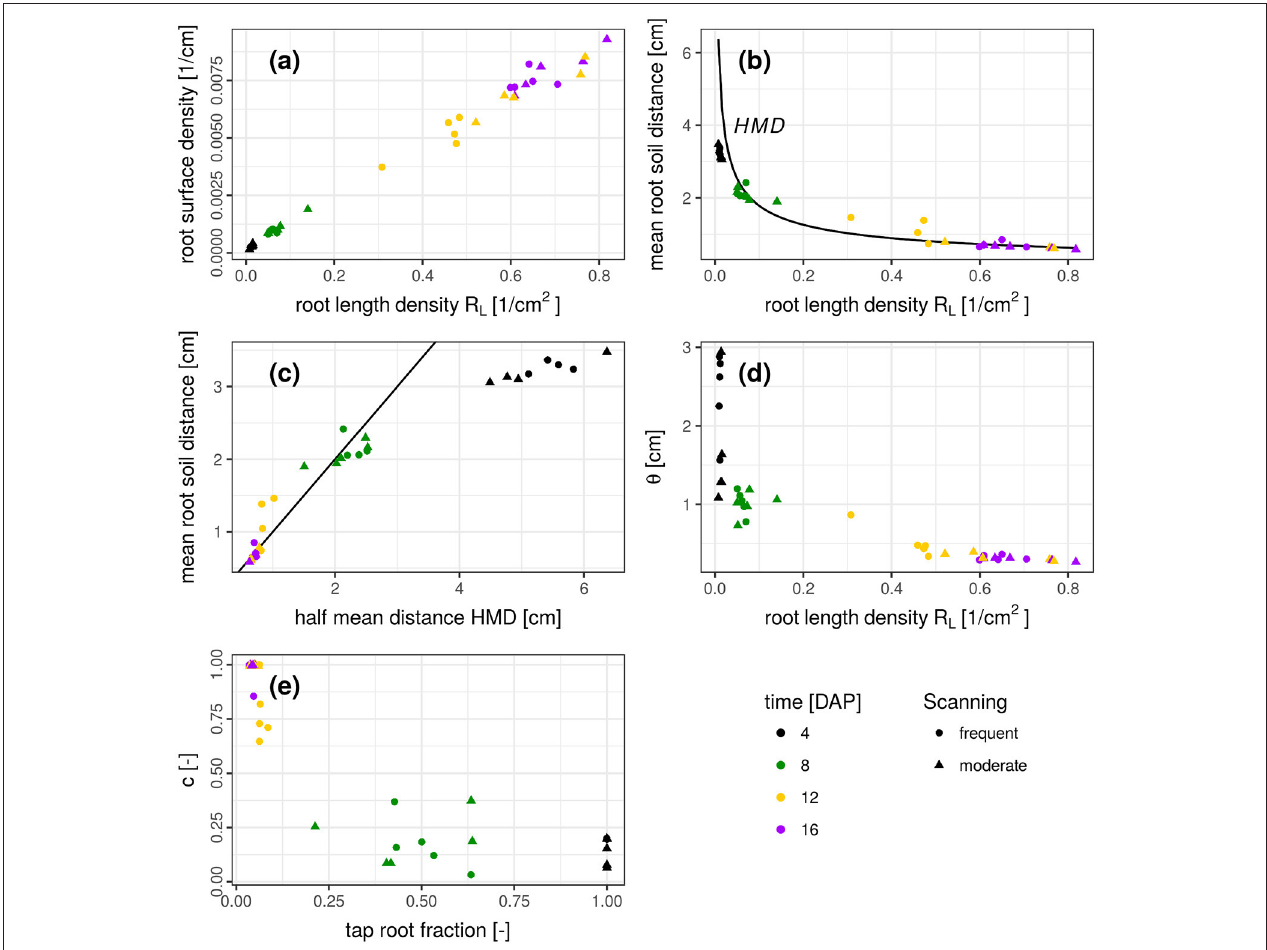
FIGURE 7 | (a-e) Relationship between several root system traits derived from a skeleton analysis (root length density, half mean distance, tap root fraction) and root distance traits derived from mixed triangular-gamma models (relative root surface, mean root-soil distance, i.e., first central moment of the root distance histogram, and the parameters θ and c ). Root system traits are shown on the abscissa and root distance traits on the ordinate. In (b) , the half mean distance derived from root length density is added as a reference for comparison (black line). In (c) , the 1:1 line is